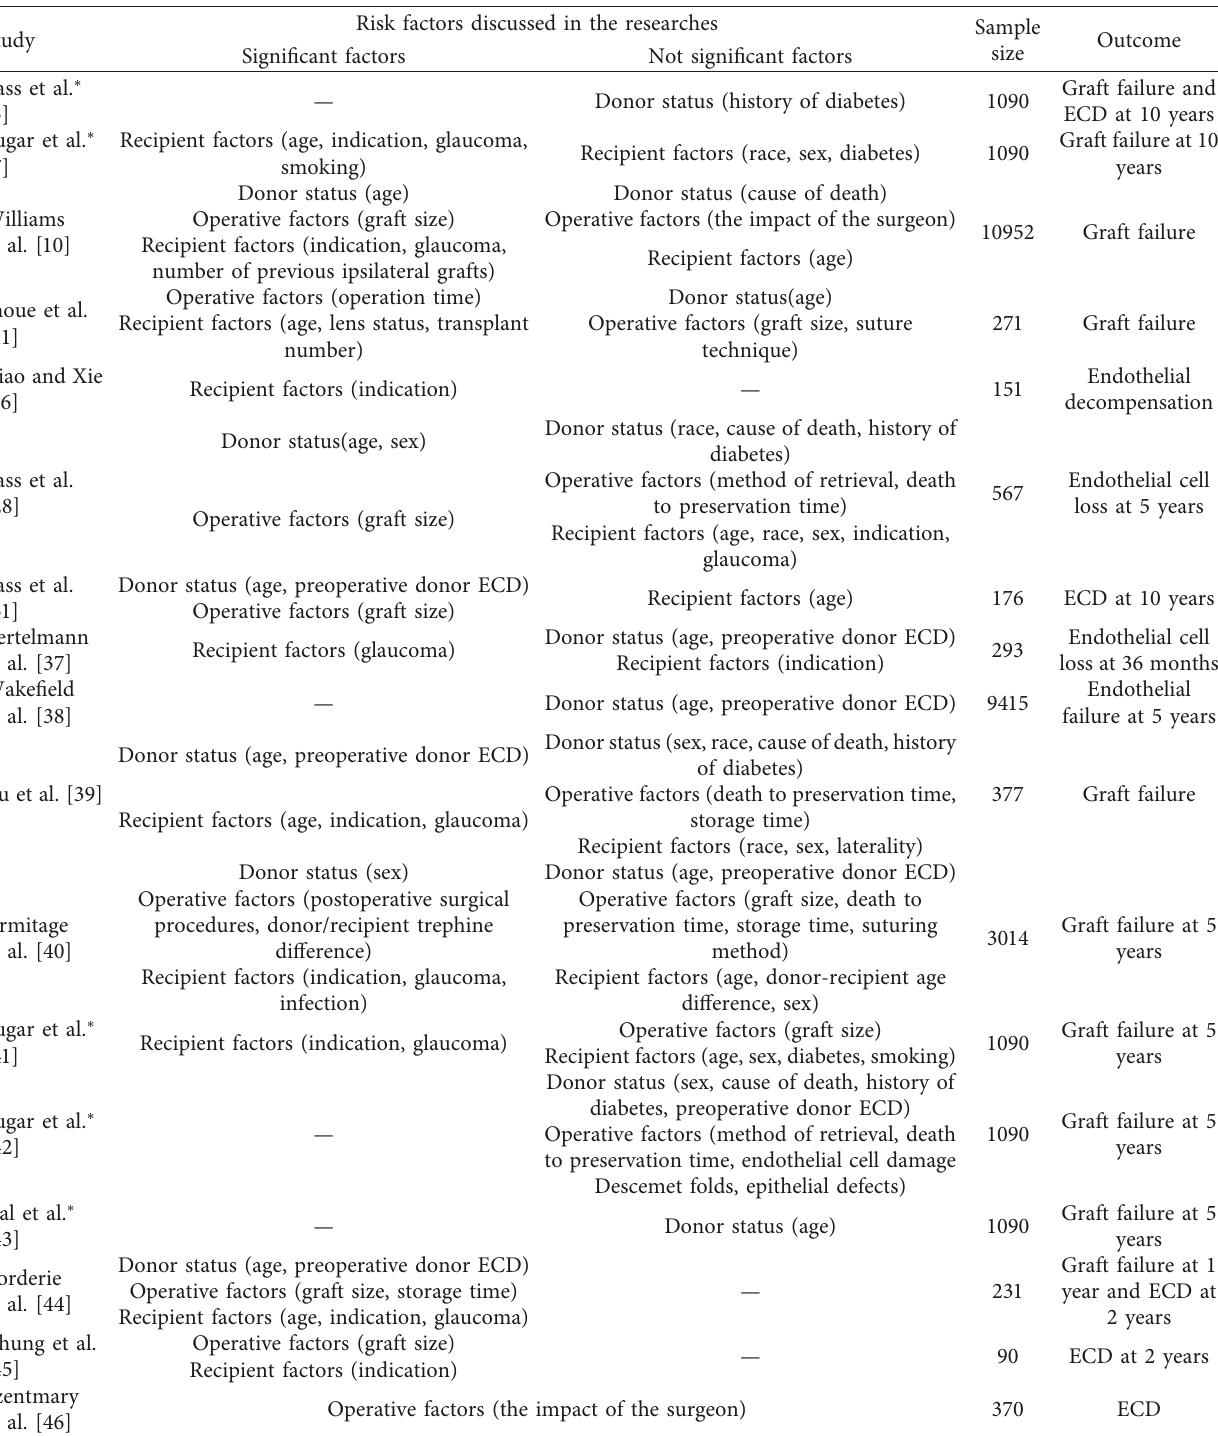
Table 3: Studies on risk factors for endothelial